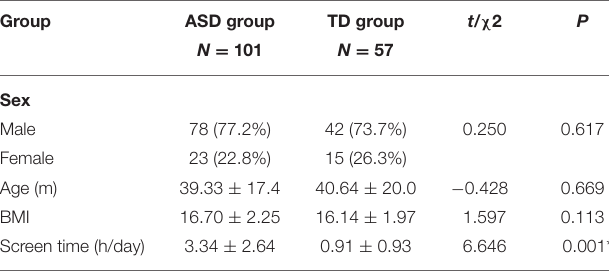
TABLE 1 | Comparison of sex, age, BMI, and screen time between the two groups.